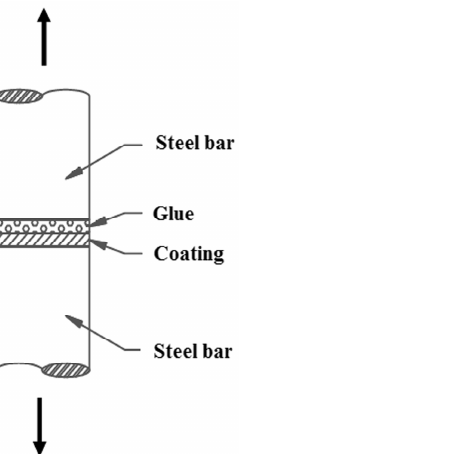
Figure 2. Adhesive glue with a tensile fracture strength of over 70 MPa was used.